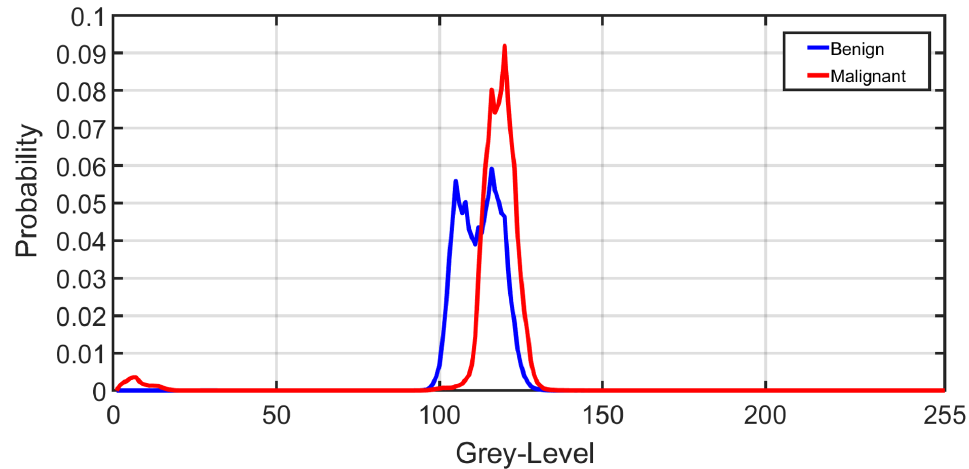
Figure 6. A visualization of the average normalized histogram curves for all benign subjects (blue) vs. malignant (red).